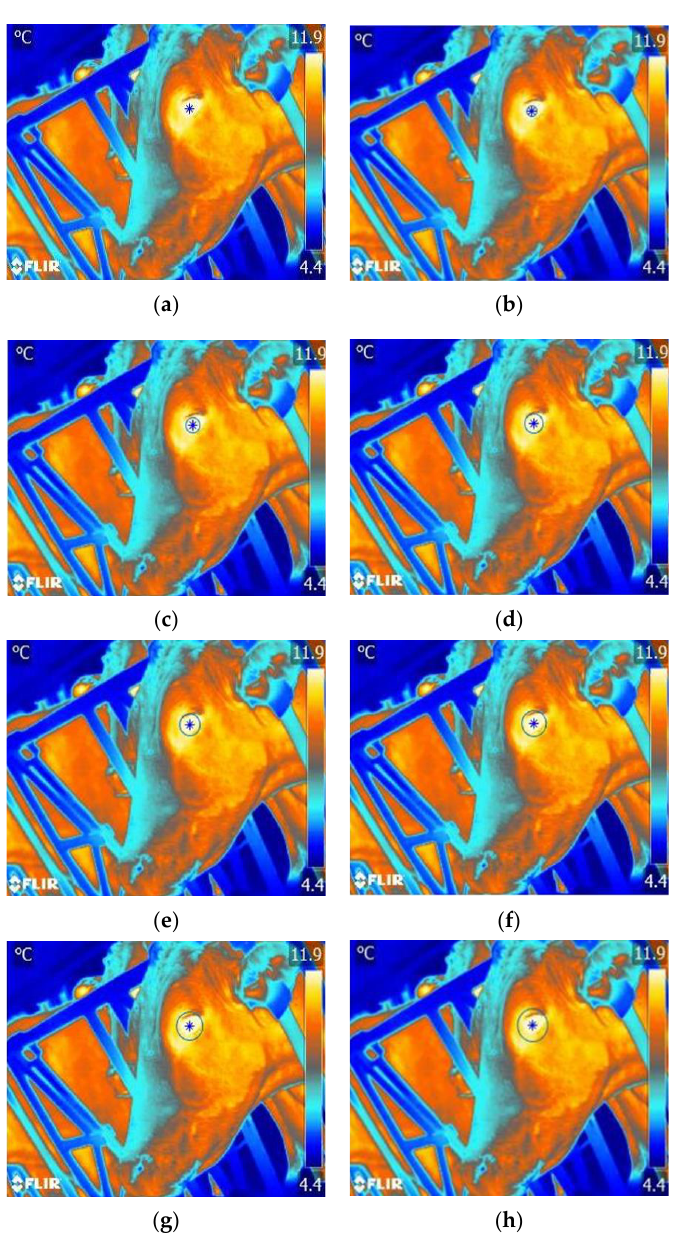
Figure 8. Results of eye marking of cows with different radii. ( a ) r = 0, ( b ) r = 5, ( c ) r = 10, ( d ) r = 12, ( e )r = 14, ( f ) r = 16, ( g ) r = 18, and ( h ) r = 20. ( e ) r = 14, ( f ) r = 16, ( g ) r = 18, and ( h ) r =